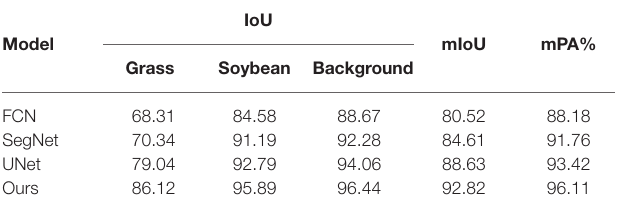
TABLE 1 | Performance comparison of the different models.